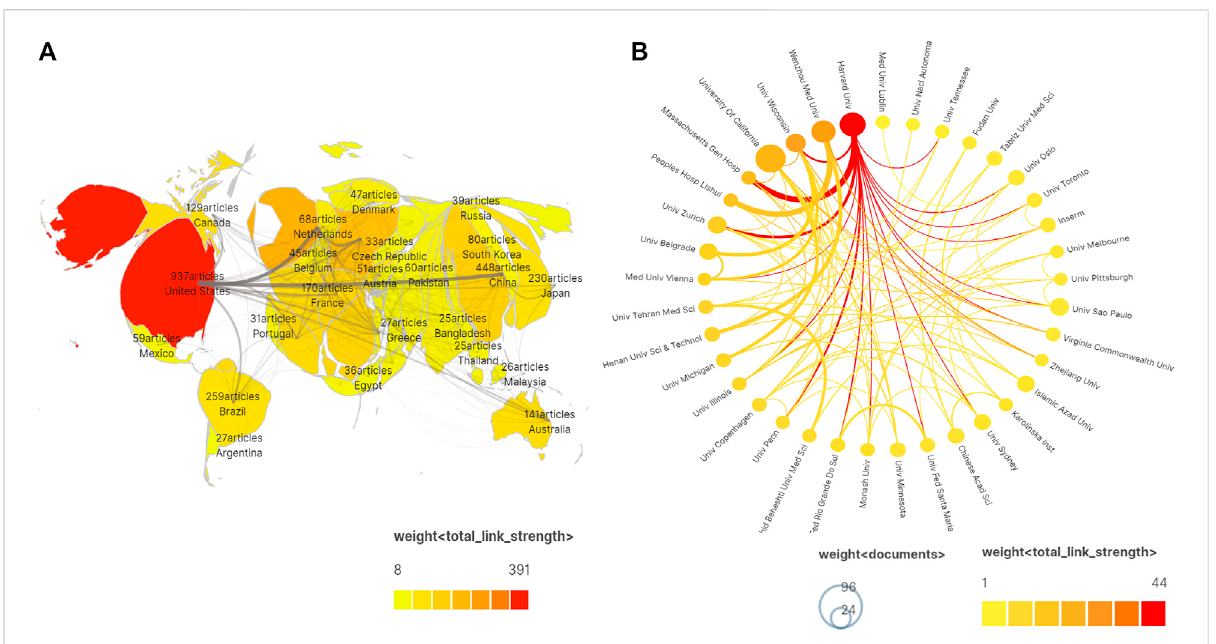
cooperation between countries/institutions; denser lines and a deeper shade of color correspond with closer cooperation.